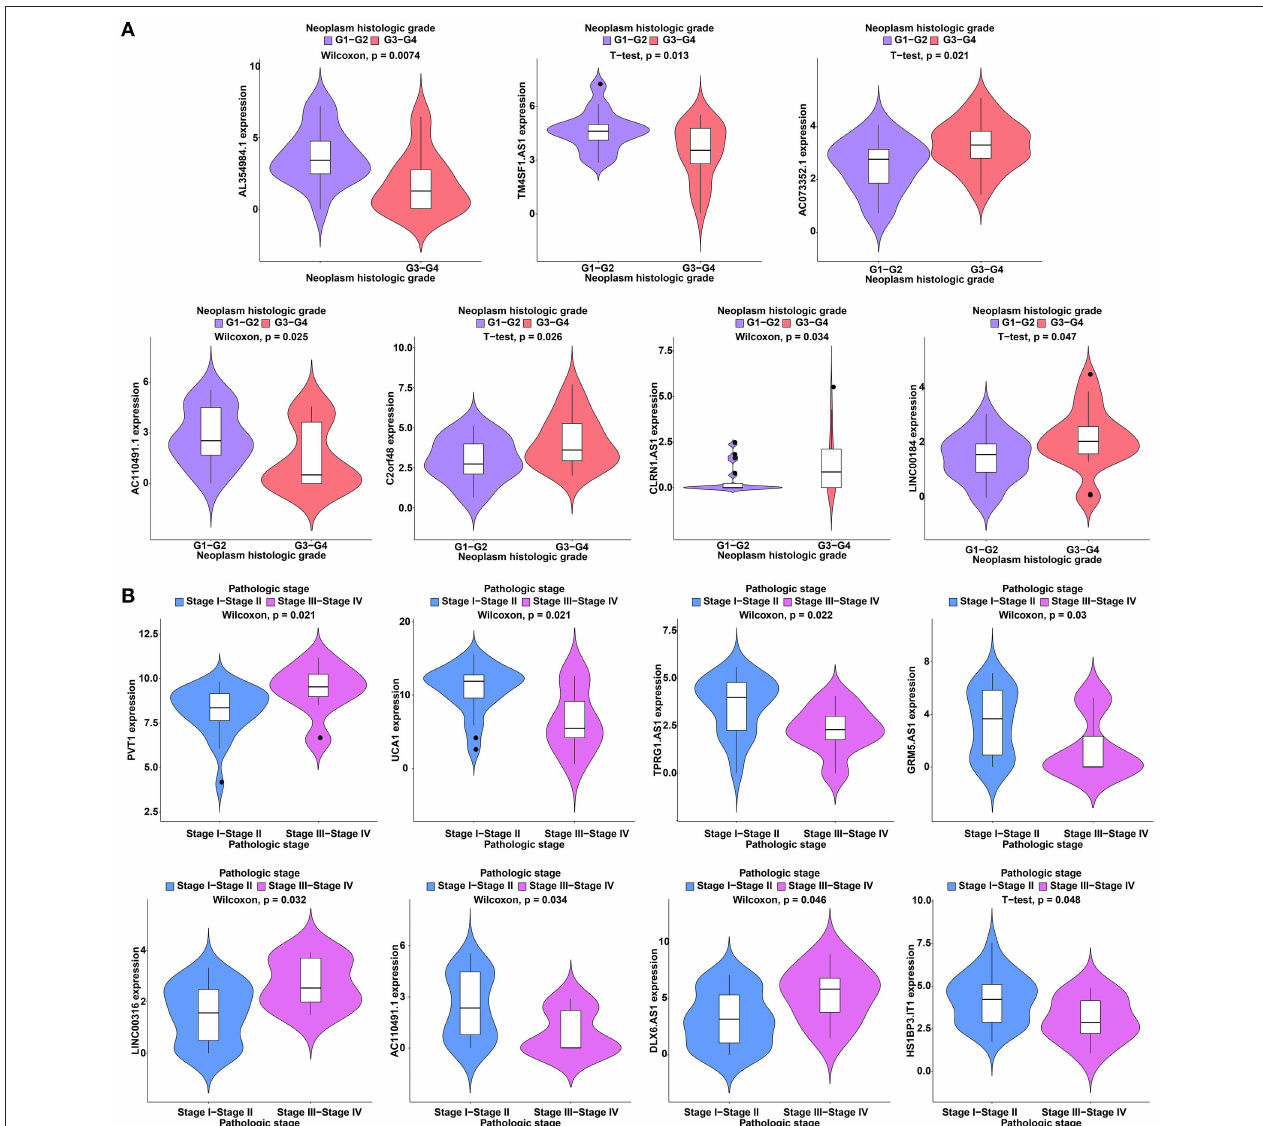
FIGURE 8 | Clinical feature analysis of DElncRNAs in the ceRNA network. The correlation between DElncRNAs involved in the ceRNA network and neoplasm histologic grade (A) and pathologic stage (B) .